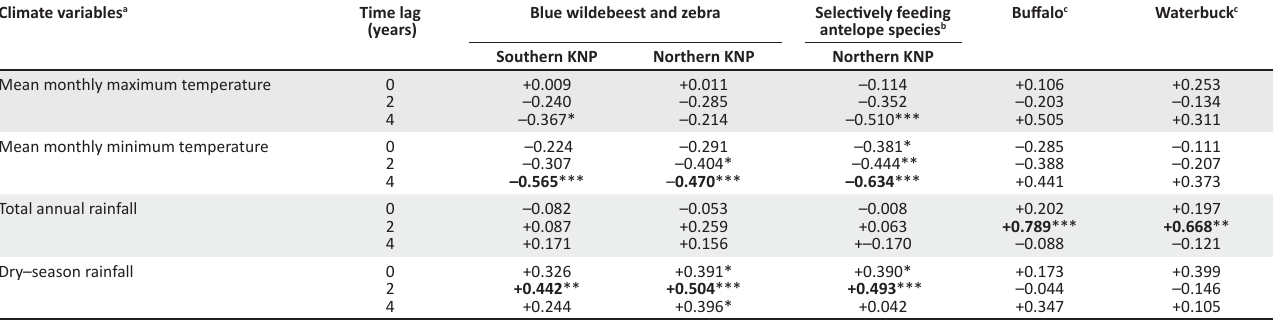
TABLE 2: Spearman rank correlations of population performance trend ratings with climate variables for blue wildebeest/zebra, selectively feeding antelope species groups (Figure 6), buffalo and waterbuck. Climate variables